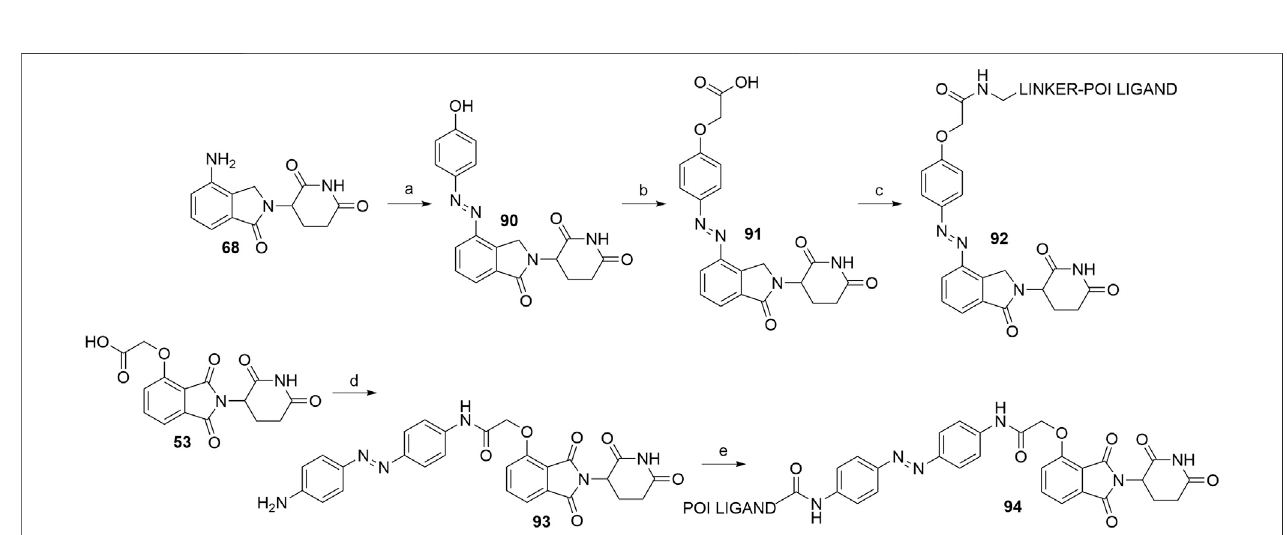
SCHEME 19 | Syntheses of CRBN-targeting PHOTACs 92 and 94 . Reagents and conditions: a) i. 1 M HCl, HBF 4 , 2 M NaNO 2 , 0 ° C, 1 h; ii. phenol, NaHCO 3 ,